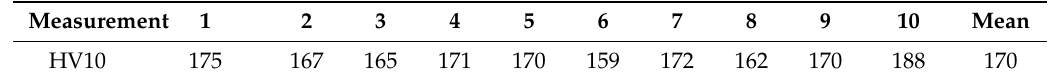
Table 2. Vickers HV10 hardness measurements results.